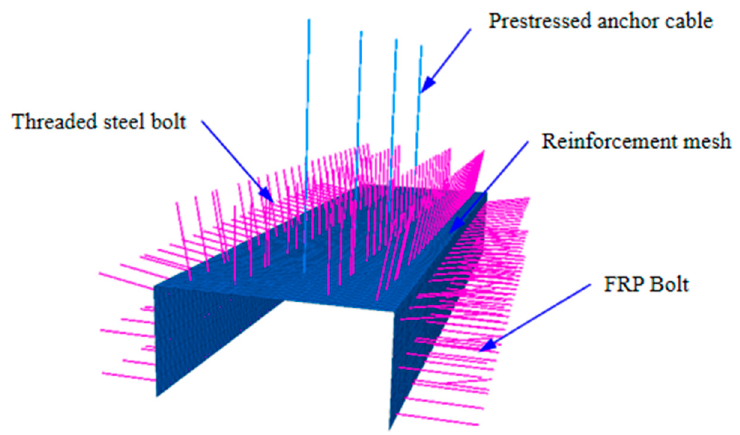
Figure 7. Realization method of 3D modeling support structure simulation.